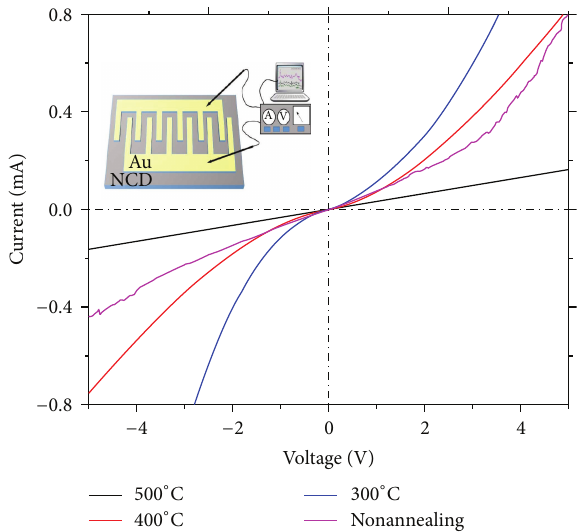
Figure6: I-V characteristicsoftheas-fabricatedNCD/Austructures for UV photodetector device.